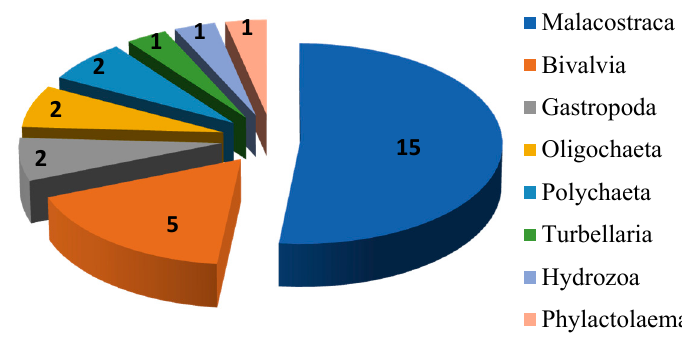
Figure 2. Number of alien species per taxonomic group.